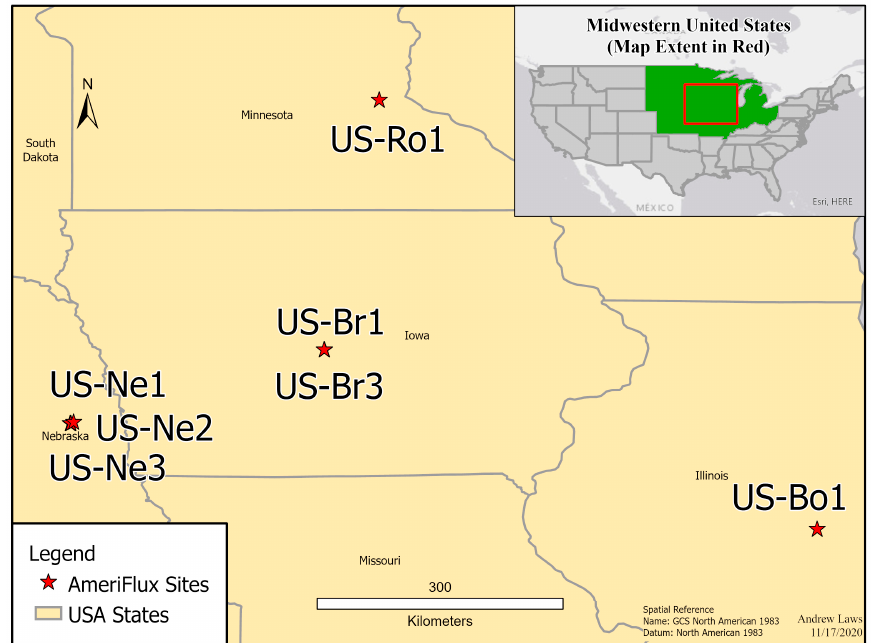
Figure 1. Map indicating the locations of the seven agricultural AmeriFlux sites in the U.S. Midwest used in this study.